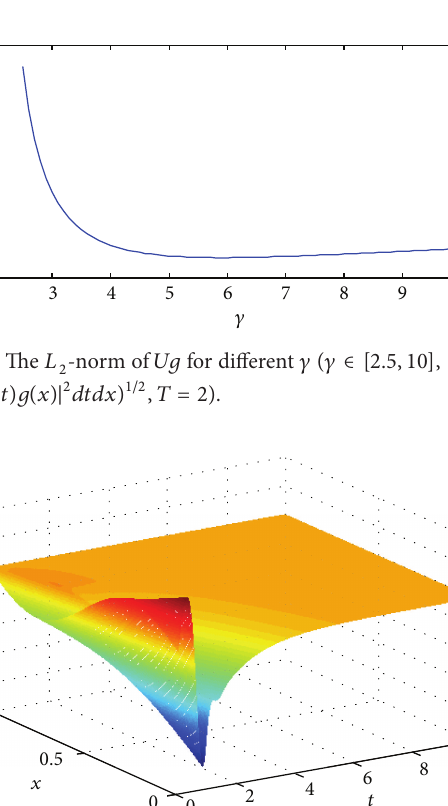
Figure 10: The response of the closed-loop system control acting on [0.7, 1] ( 𝛾 = 4.5 ).